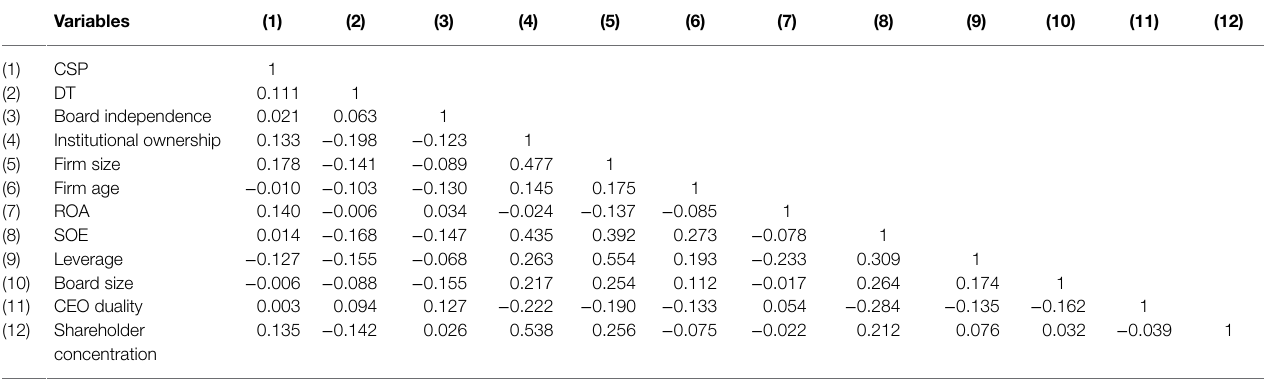
TABLE 3 | Correlation matrix.